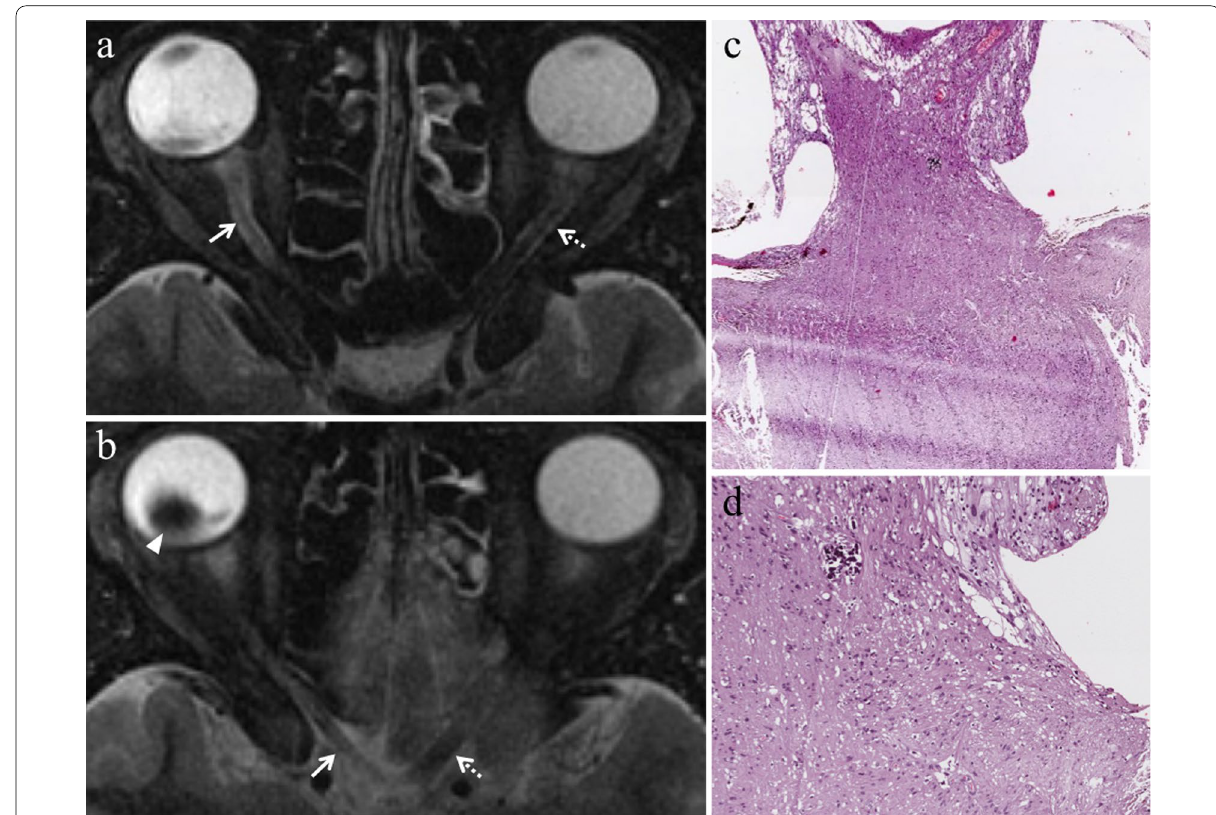
Fig. 14 A 37-year-old man with radiation-induced optic neuropathy after proton-beam radiotherapy for choroidal melanoma of the right eye. The same patient as in Fig. 9. a, b Axial T2-weighted turbo spin-echo STIR images show an intraocular lesion (white arrowhead in b ) along the posterosuperior aspect of the globe. The right optic nerve appears thinned and slightly hyperintense (white arrows) compared to the contralateral one (white dotted arrows). c Histological examination showing the optic nerve tissue with diffuse degenerative changes: a diffuse fibrosis, extensively dissociating the nerve fibres is evident (H&E, original magnification 50 ). d Histological detail showing the presence of fibrosis, × microcalcifications and microcystic changes, affecting the optic nerve and consisting with a radiotherapy-related degenerative process